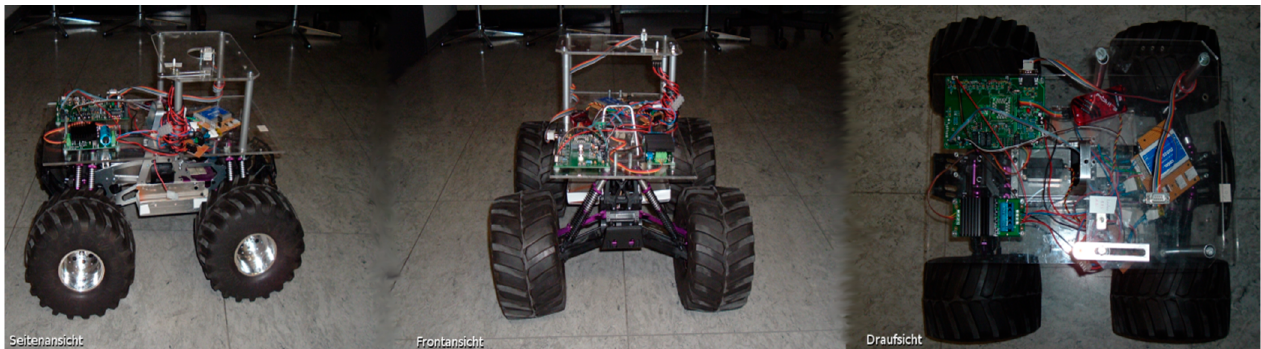
Figure 1. Monster Truck HPI Savage 2.1 with robot attachment.